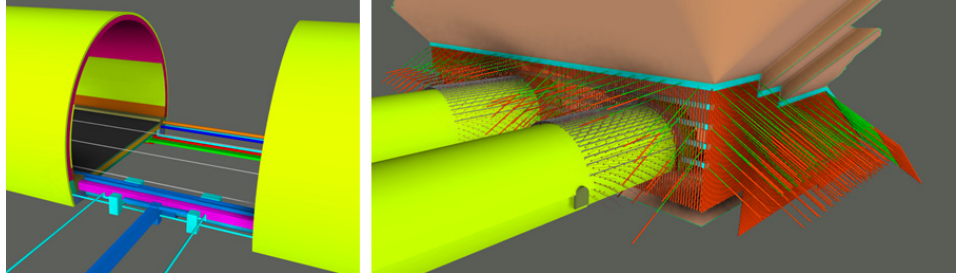
Figure 7. Critical areas in the initial model for interference detection.